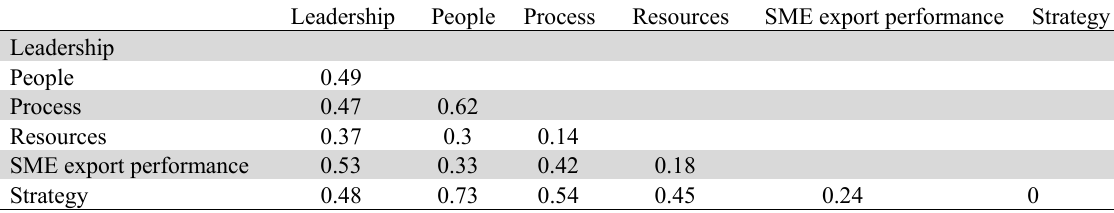
Heterotrait-Monotrait Ratio (HTMT) Leadership People Process Resources SME export performance